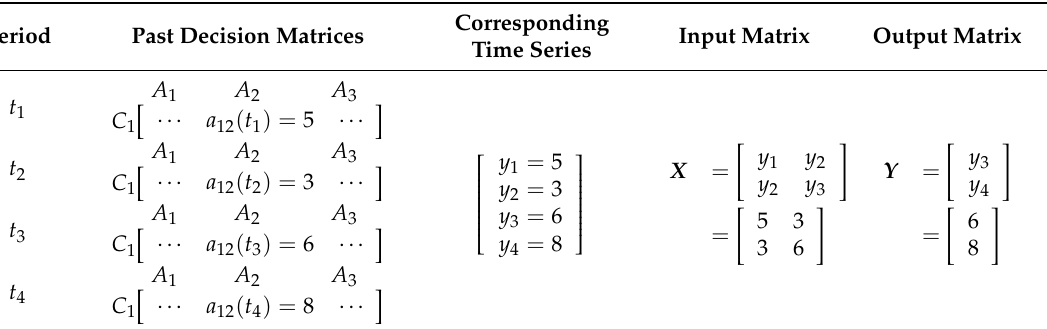
Table 1. Illustration of the four-period